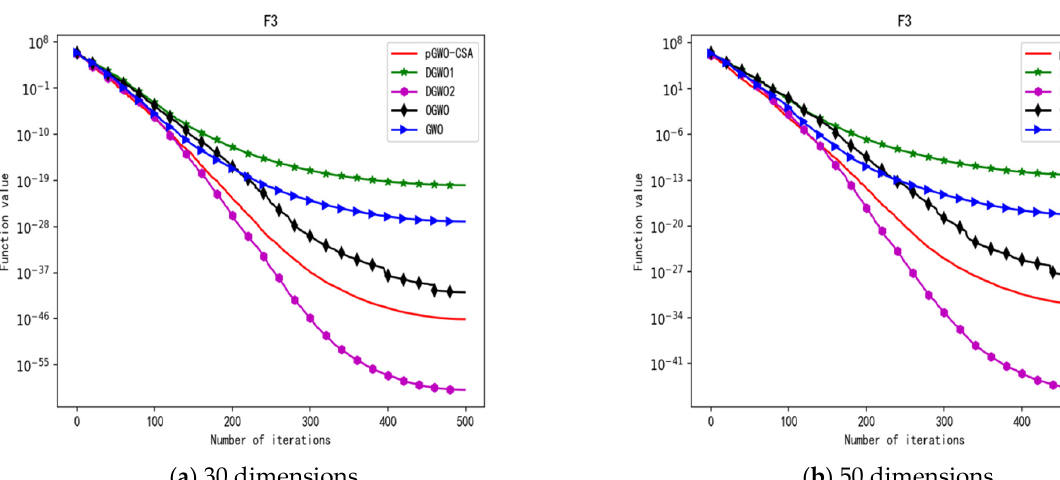
Figure 22. Convergence curve of test function F3.